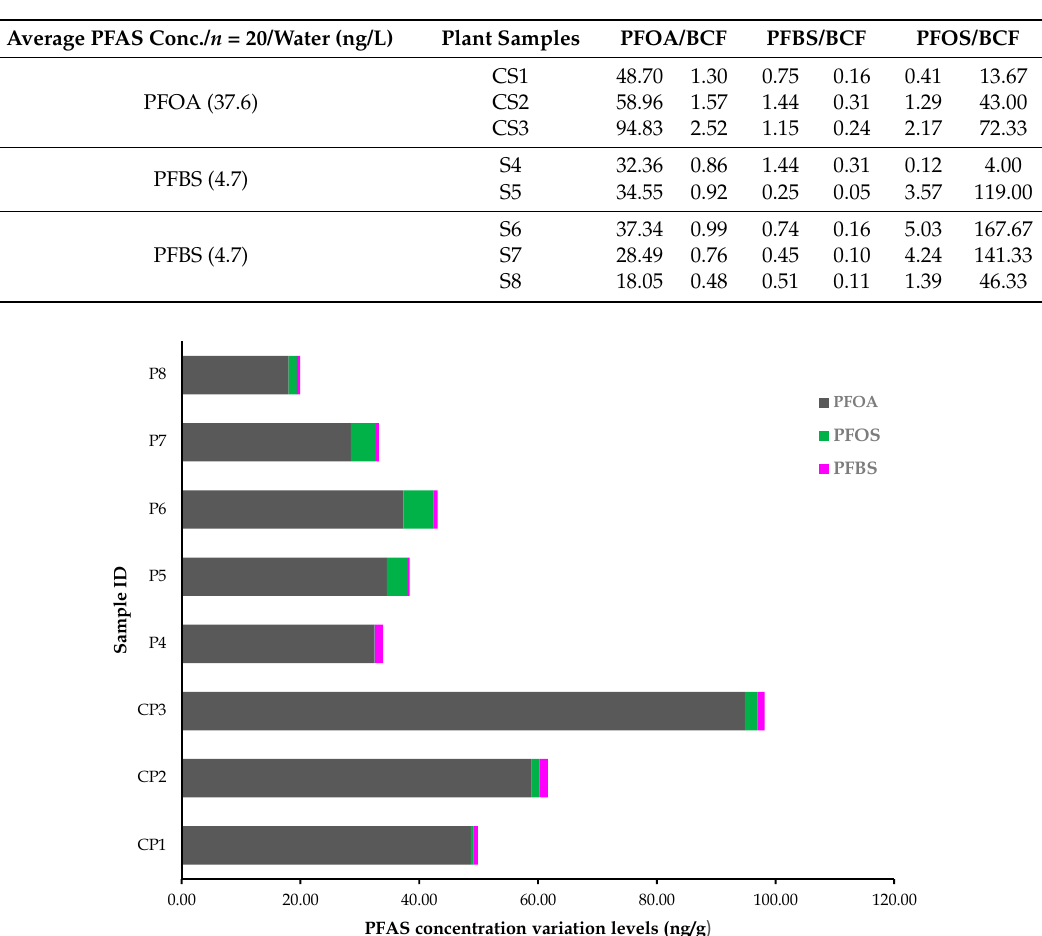
Table 3. Summary of studied plant samples ( Tagetes erecta L.), with their PFAS concentrations (ng/g) and bioconcentration factor (BCF).